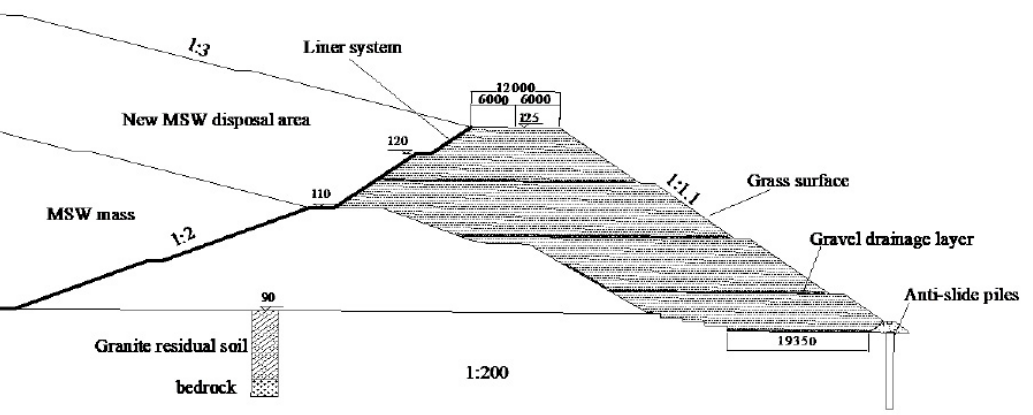
Figure 2. Typical cross section of the GRS berm (length: mm; height: m).